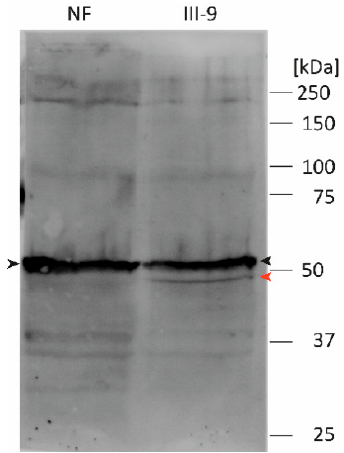
Figure 5. Western blotting analysis using myocardial tissue from a control sample (NF) and the index patient III-9. Of note, in the case of the index patient, two bands were observed, which correspond to wild-type desmin (black arrow head) and desmin-p.D214-E245del (red arrow head).